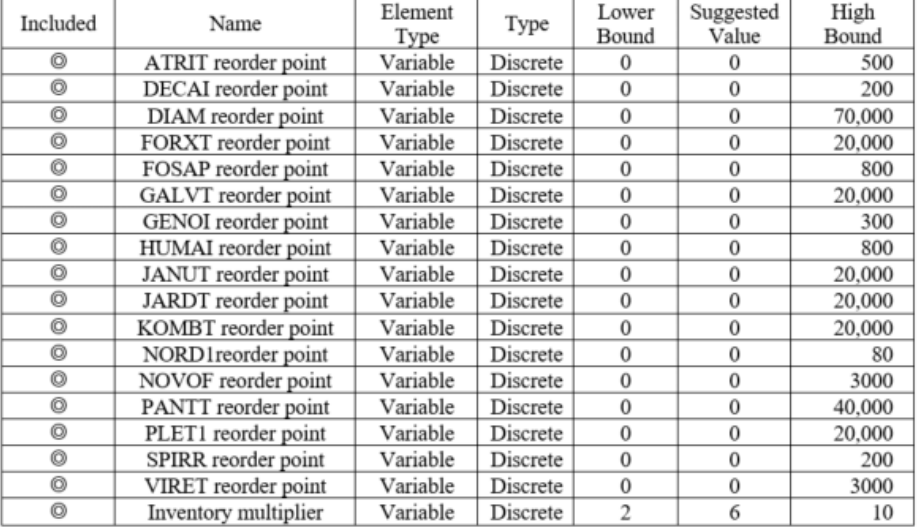
Figure 14. Setting values of decision variables for Group 1.